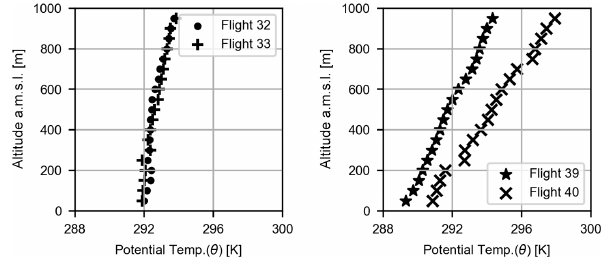
Figure 3. The vertical profiles of potential temperature measured by the aircraft during the four flights mentioned in Table 1. Each point represents an average of data points in a 50m